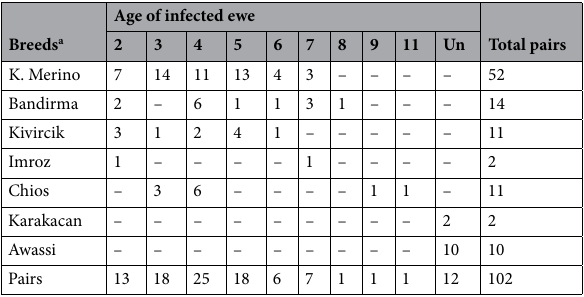
Table 2. Distribution of 102 matched case–control pairs. K Karacabey, Un